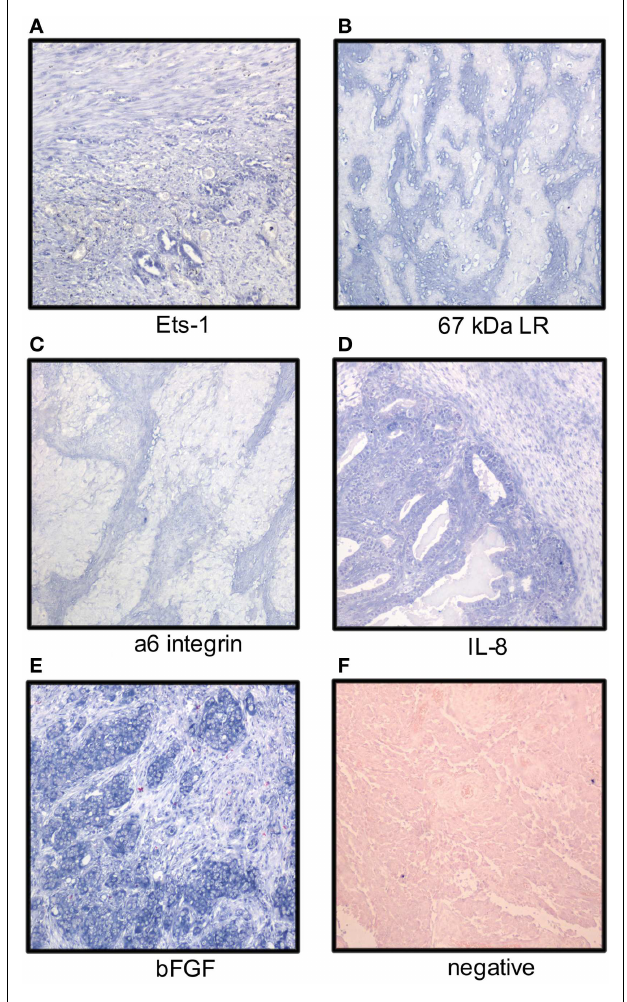
FIGURE 1 | Localization of mRNA of cancer-associated molecules to the ovarian carcinoma stroma . OC stromal cells express mRNA of the Ets-1 transcription factor (A) , laminin receptors (B,C) , and the angiogenic factors IL-8 and bFGF (D,E) ; (F) negative control.Tumor cells express Ets-1, IL-8, and bFGF (NBT-BCIP as chromogen, nuclear fast red as